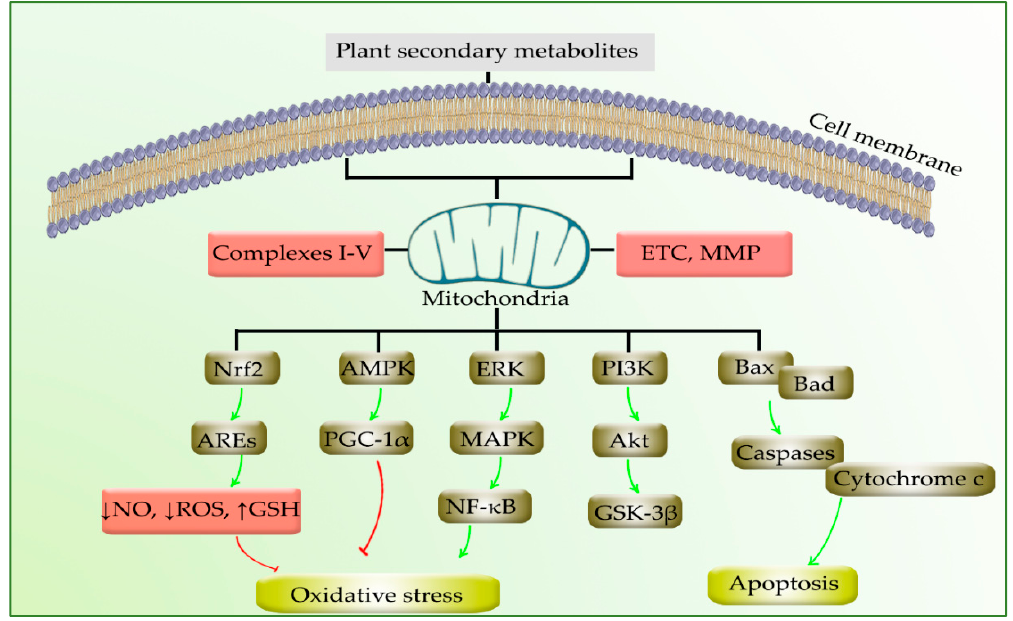
Figure 4. Phytochemicals employ several mechanisms in the treatment of PD passing through mitochondria.